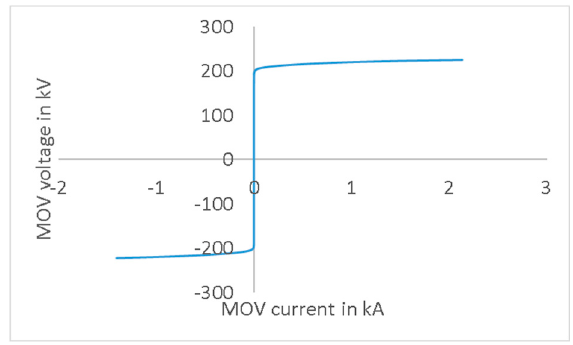
Figure 17. The MOV characteristics.